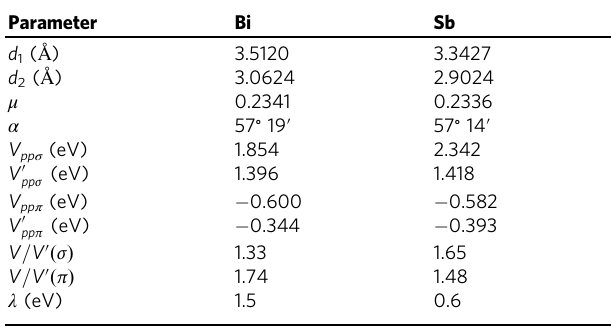
Table 2 A comparison of bismuth and antimony.